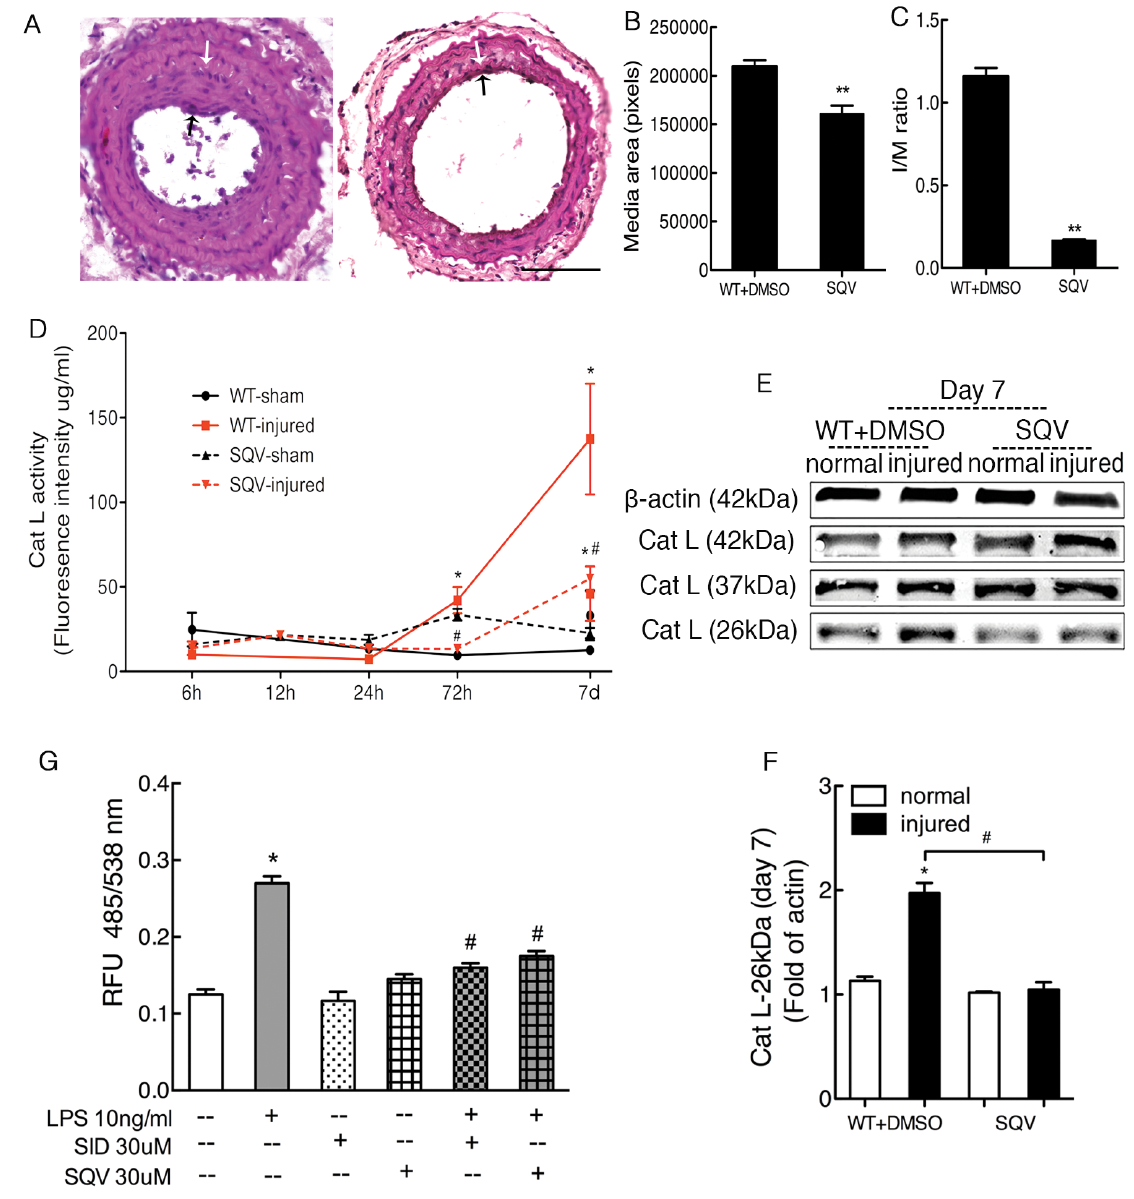
Figure 3. Saquinavir inhibits cathepsin L activity and intimal hyperplasia. (A–C) Administration of SQV ameliorates intimal hyperplasia in wild-type mice. SQV (saquinavir 5mg/kg and ritonavir 1.25mg/kg) or DSMO control was administered intraperitoneally once daily 3 d before surgery and 28 d after surgery. The ratios of intima and media area and vessel medial size were quantified by planimetry at 28 d. Representative hematoxylin and eosin stained sections of carotid arteries from control mice (n = 7) and SQV-treated mice (n = 8) are shown. The white arrows indicate internal elastic lamina. The black arrows indicate luminal side of the artery. (D) Arterial enzyme activity for cathepsin L was measured by a fluorescence-based assay and normalized to tissue extract protein concentration at indicated time points following wire injury. Cathepsin L activity of the injured and the uninjured carotid arteries from control and SQV-treated mice are displayed (n = 4 at each time point). * P <0.05 versus sham group. # P <0.05 versus the wild-type injured group. (E,F) Tissue lysates from aortic arteries (30 μ g) were prepared from DMSO control and SQV-treated mice at 7 d after injury and subjected to western blot assay for cathepsin L (n = 4). * P <0.05 versus sham group. # P < 0.05 versus the wild-type injured group. (G) Quantification of THP-1 cell adhesion to HUVEC. THP-1 with treatment as indicated was labeled with the calcein AM and added to confluent monolayers of HUVEC. The plate was read at 485/538 nm in a fluorescent plate reader. Quantitative analysis of binding of THP-1 cells to HUVEC is presented with bar graphs of fluorescence values. Data represent the means ± SEM. * P <0.05 versus control. # P <0.05 versus LPS group. Scale bar represents 100 μ